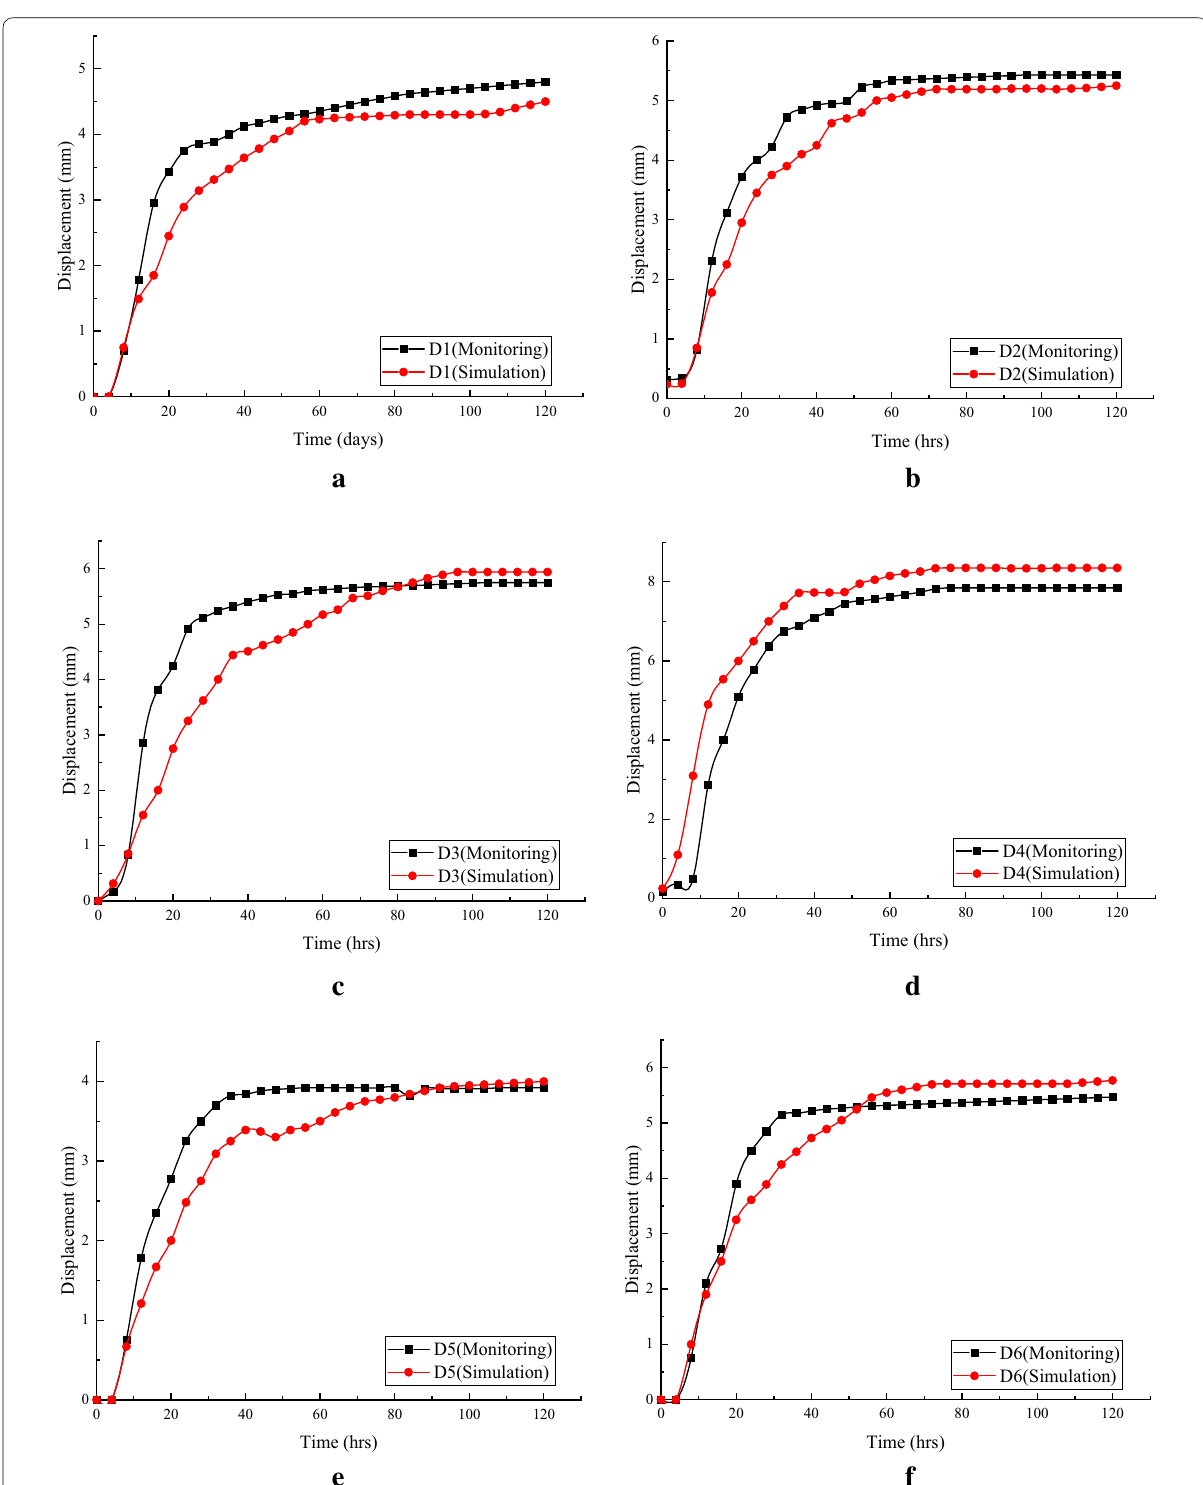
Fig. 10 Comparison between the predicted and measured barricade displacement corresponding to the monitoring transducers of D1 ( a ), D2 ( b ), D3 ( c ), D4 ( d ), D5 ( e ) and D6 ( f